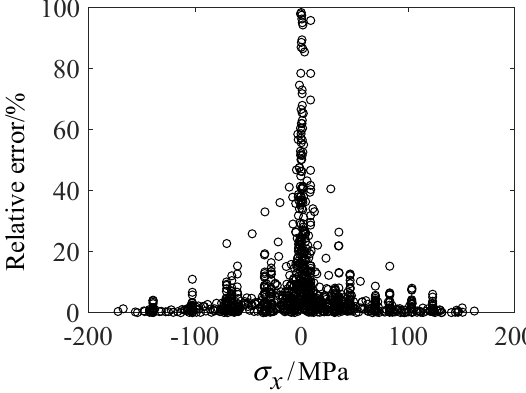
Figure 7. Relative error versus element stress.